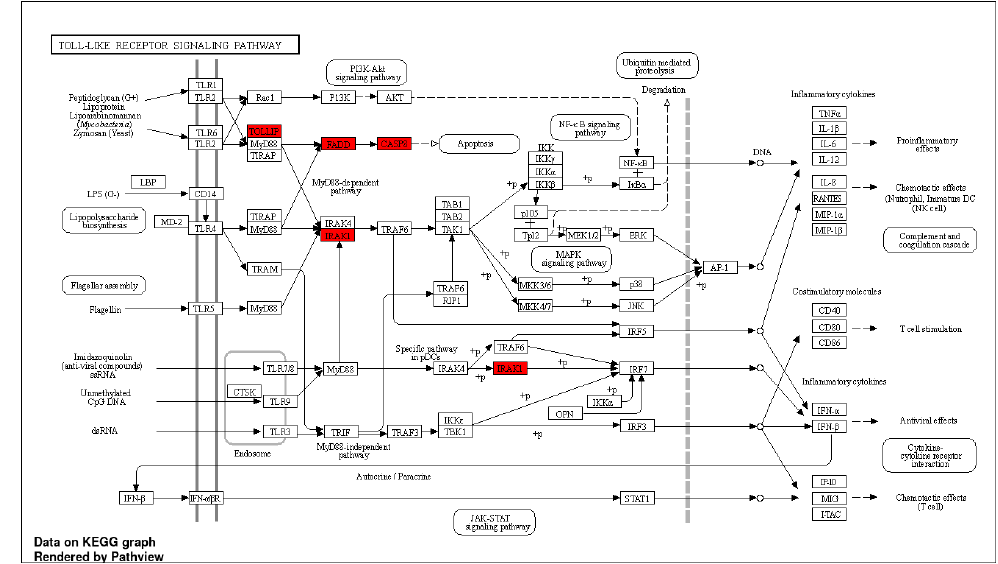
Figure 6. Toll-like receptor signaling pathway including miRNA-146a and miRNA-126 validated target genes (highlighted in red), according to the KEGG database.